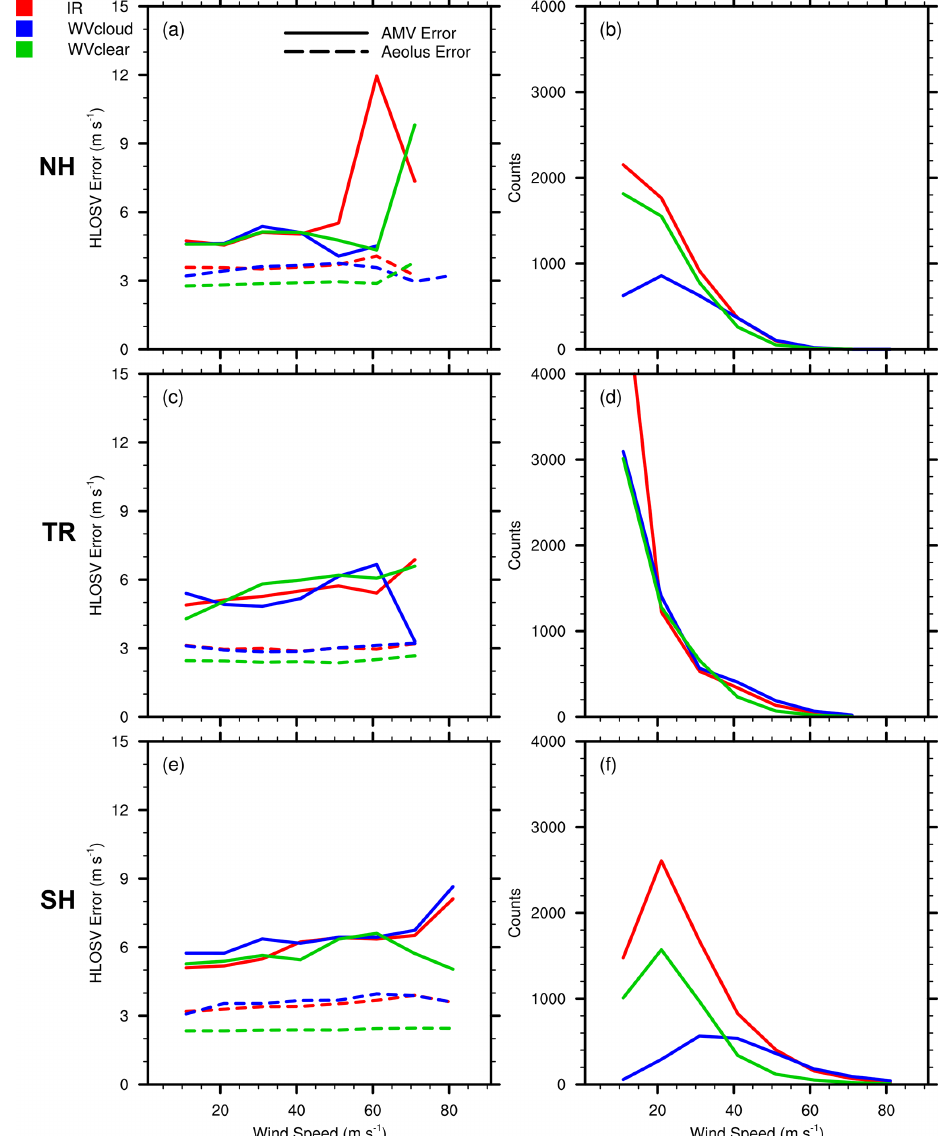
Figure 8. AMV HLOSV error (SDCD–Aeolus uncertainty) derived from GOES-16 RAY comparisons (solid lines; ms − 1 ) and Aeolus L2B uncertainty (dashed lines; ms − 1 ) with respect to AMV wind speed binned at 10ms − 1 for (a) NH, (c) tropics (TRs), and (e) SH. (b, d, f) Counts per 10ms − 1 bin for each